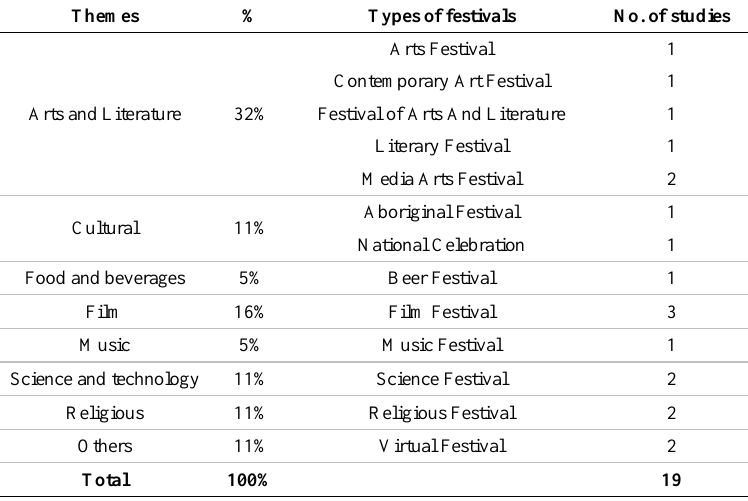
Table 2. Themes and types of festival studied in the articles